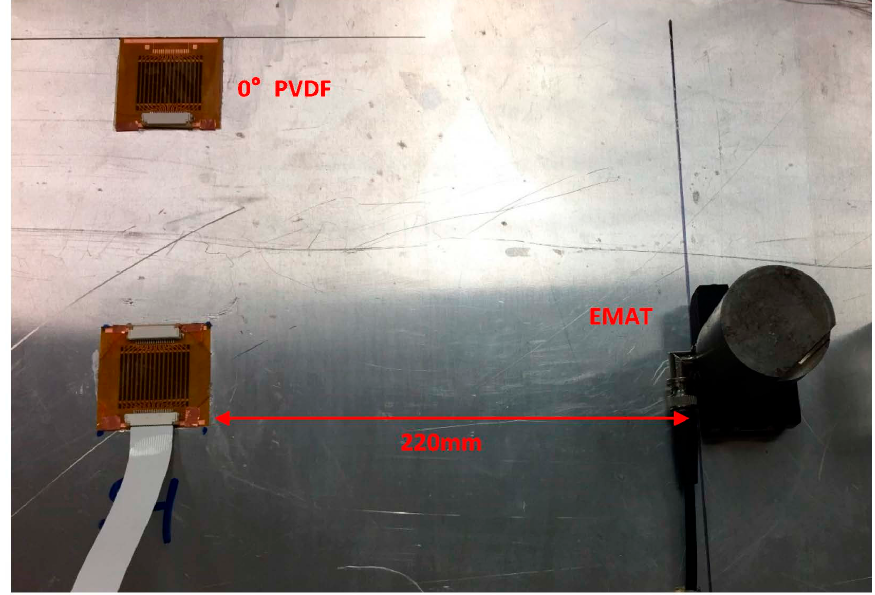
Figure 10. Experimental setup for PVDF sensors to receive SH waves.